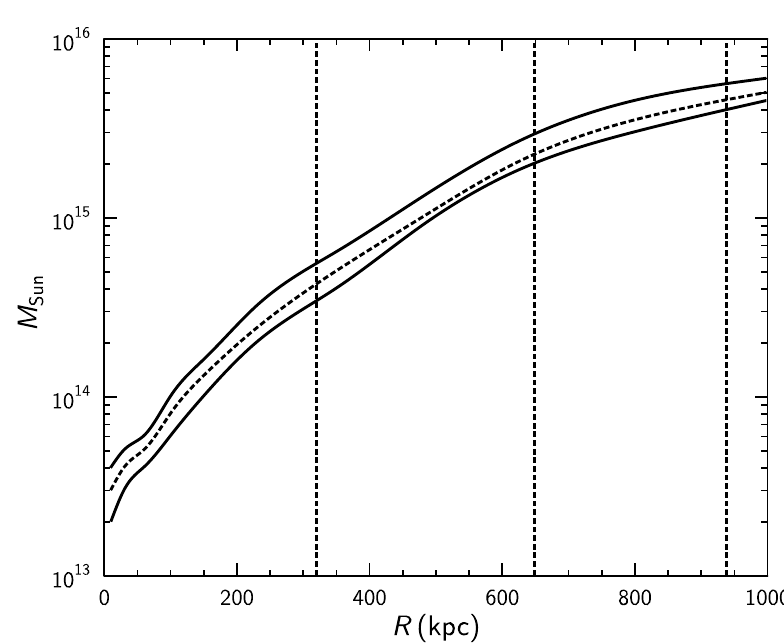
Fig. 5. The total mass pro(cid:12)le for CLJ1415 (dotted line). Two solid lines above and below the pro(cid:12)le demonstrate 1 (cid:27) con(cid:12)dence level. The dashed vertical lines show R 2500 , R 500 and R 200 , from left to